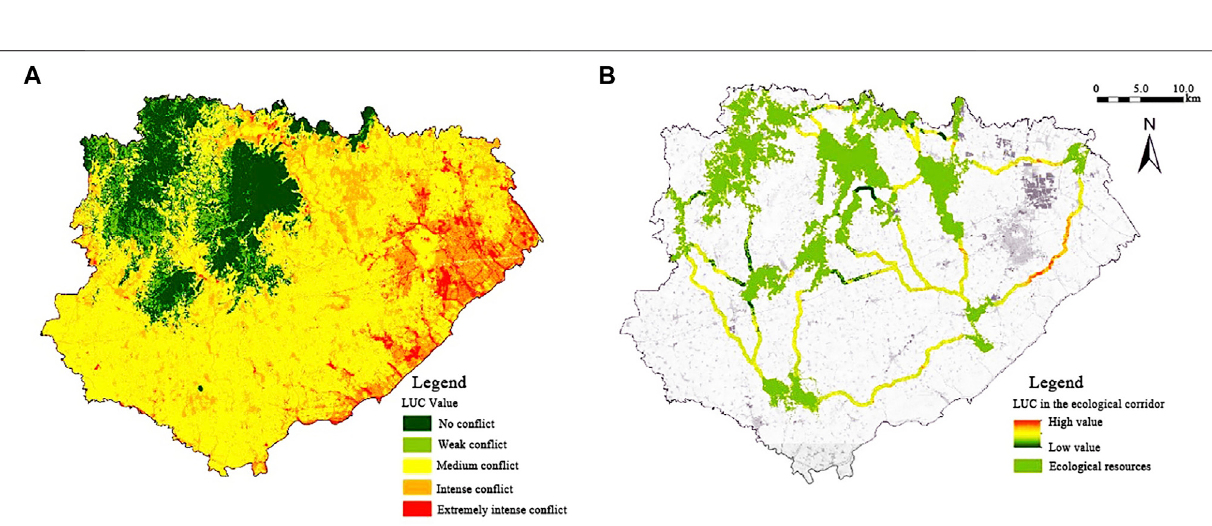
Frontiers in Earth Science |